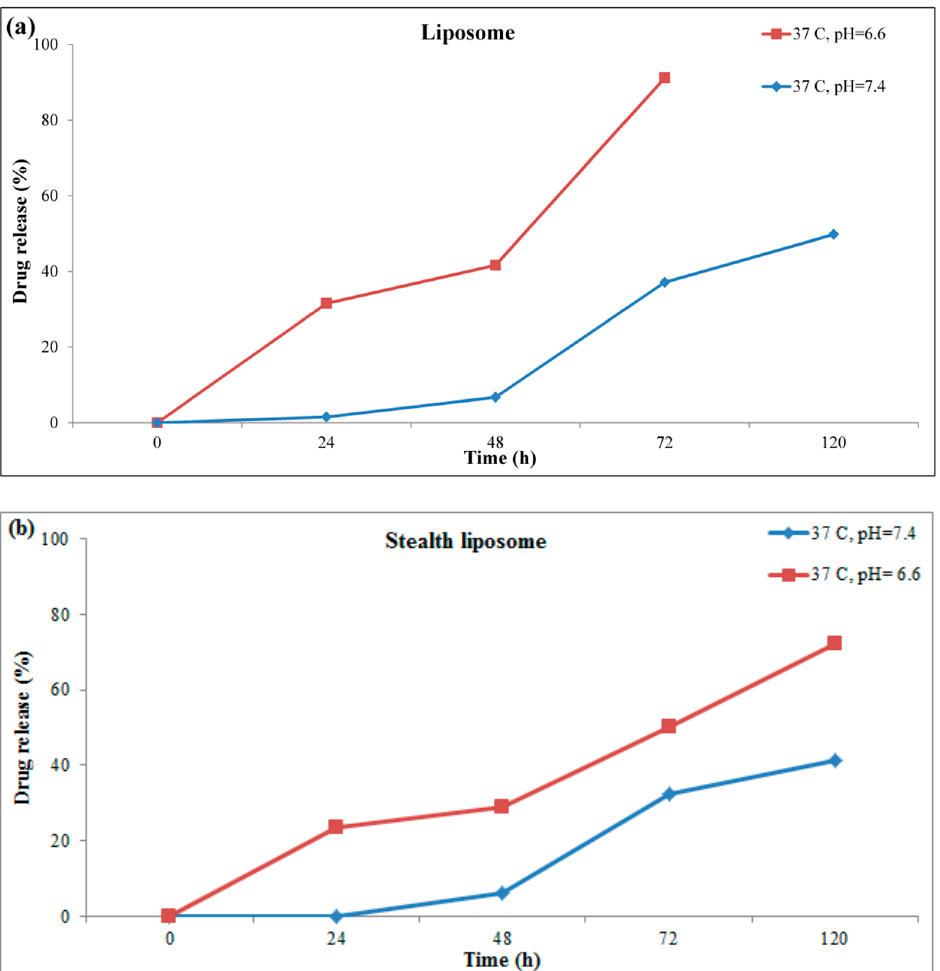
Figure 6. pH ‐ responsive drug released profile of ( a ) liposome, and ( b ) stealth liposome, after 3 months at 37 °C.